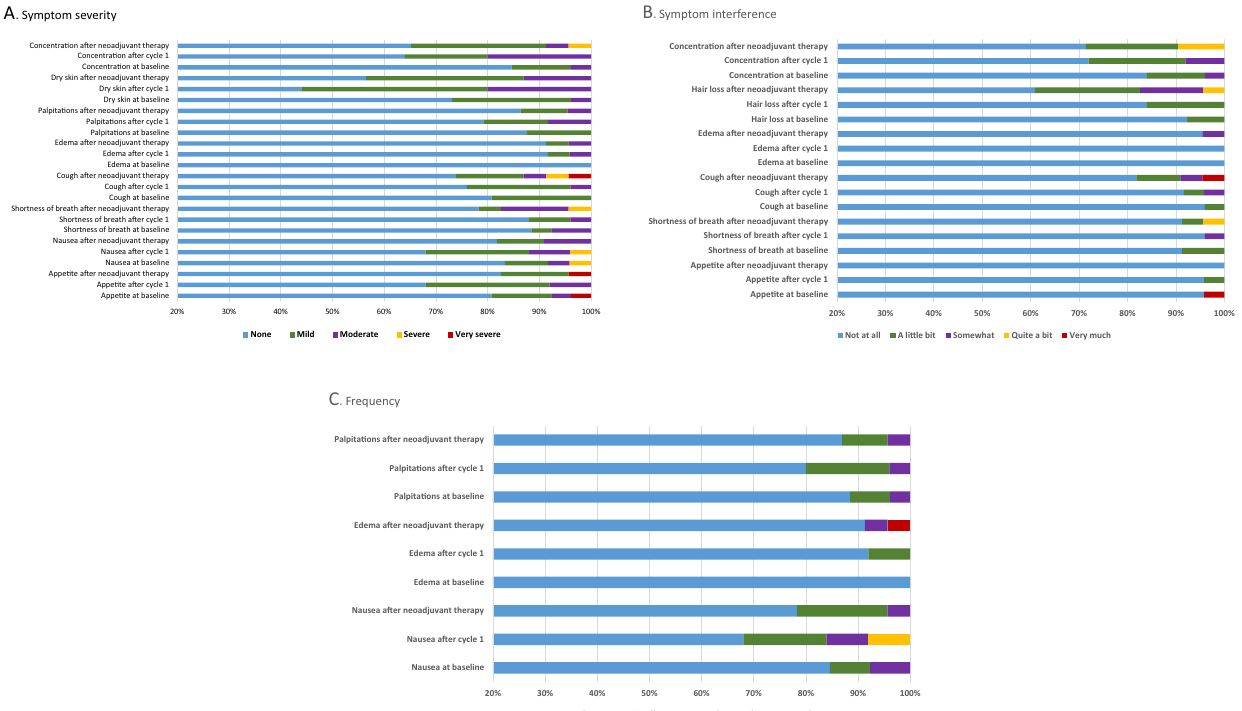
Fig. 1 Patient-reported outcomes collected at baseline, after cycle 1, and after neoadjuvant therapy using NCI PRO-CTCAE. A Severity, B interference, and C frequency.